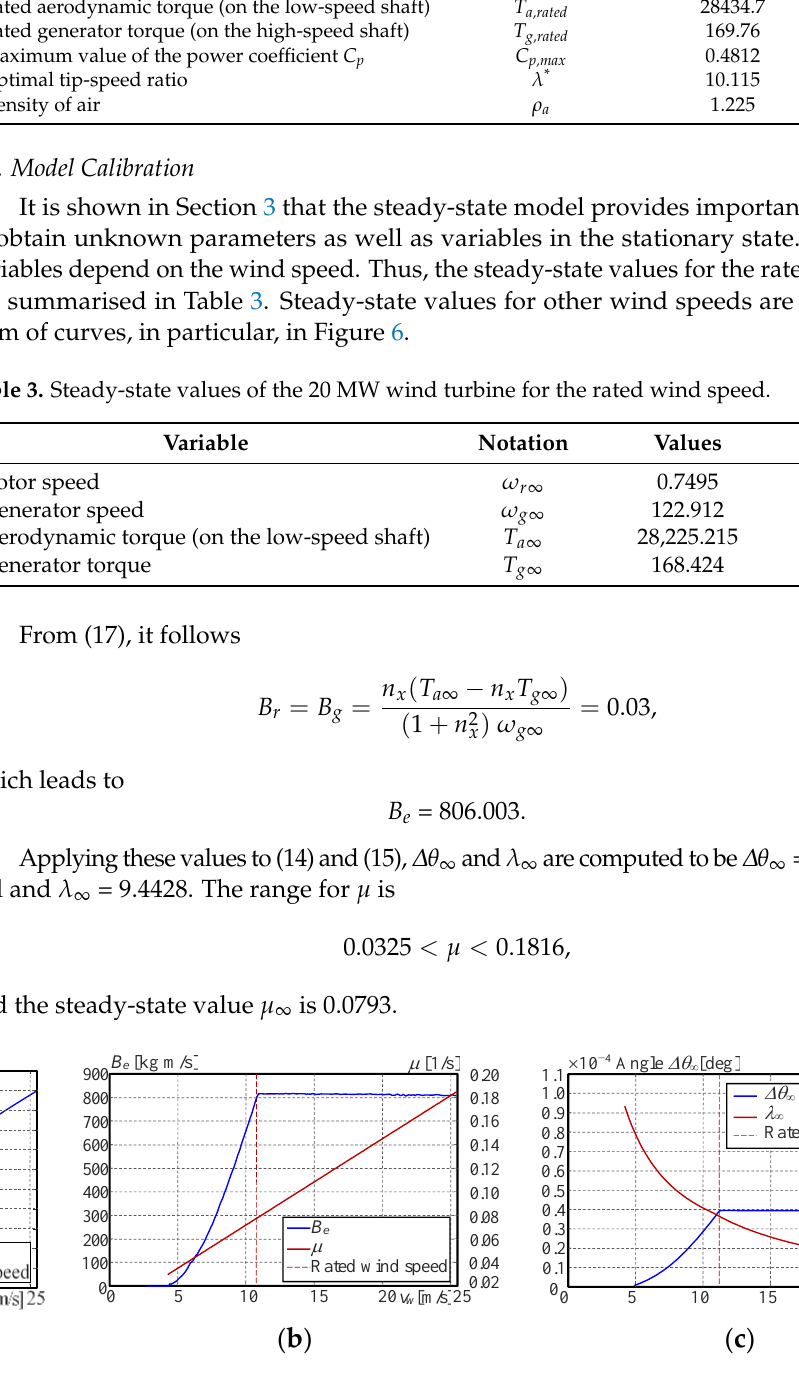
Table 3. Steady-state values of the 20 MW wind turbine for the rated wind speed.